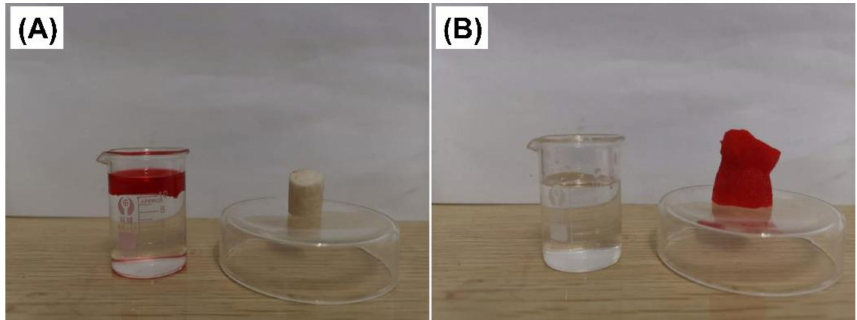
Figure 5. Oil / water separation of P(LA- co -EGDMA) cryogels before ( A ) and after ( B ) dropping cryogels into oil / water mixture (with toluene as the representative).